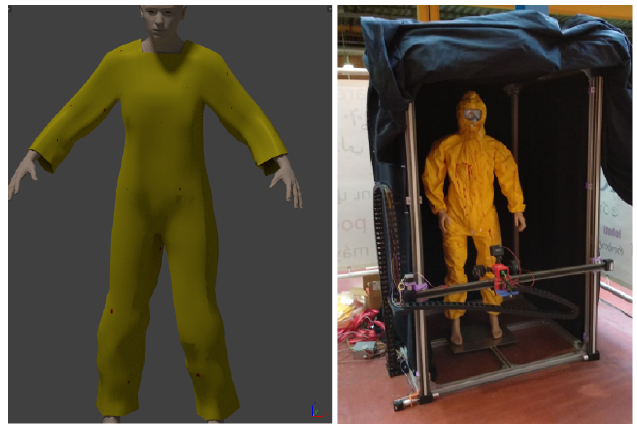
Figure 4. Comparison between the PPE suit of the simulated environment ( left ) and the physical PPE suit in the actual full-body scanner mechanism ( right ).